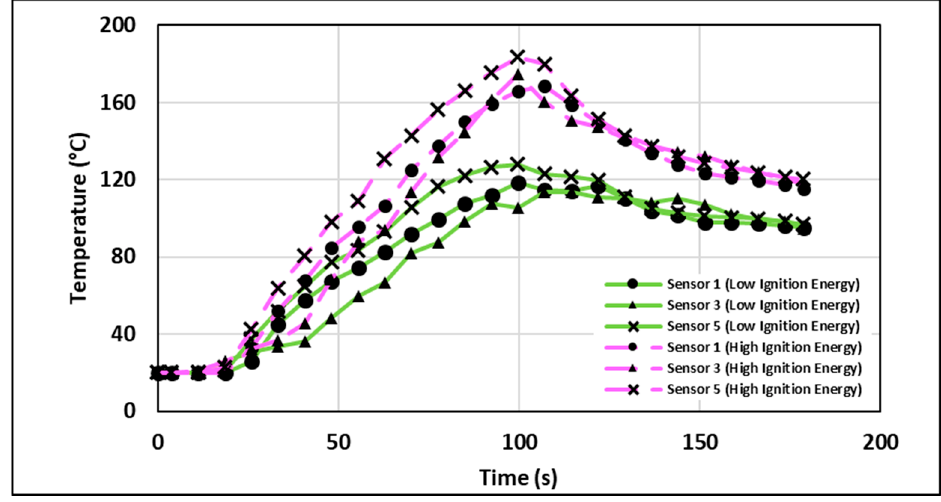
( a ) Figure 11. Cont